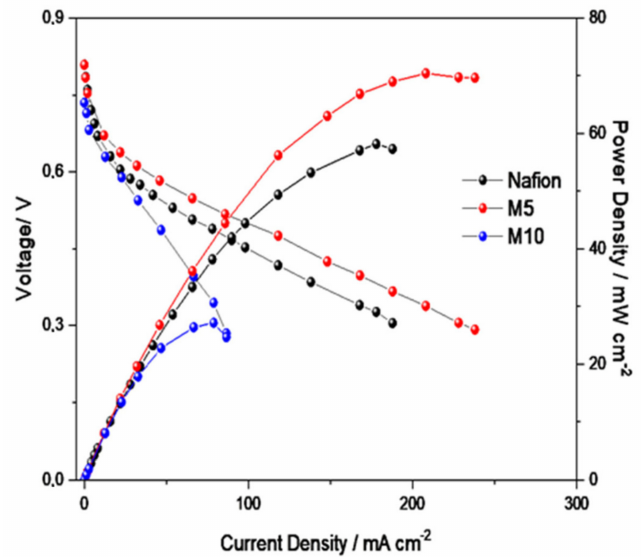
Figure 7. Polarization and power density curves at 110 ◦ C and 2 M methanol concentration at the anode for the DMFCs based on the di ff erent membranes, filler-free Nafion, Nafion with 5 wt.% CTO (M5) and Nafion with 10 wt.% CTO